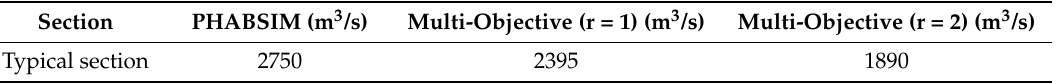
Table 5. Ecological flow calculation based on the multi-objective